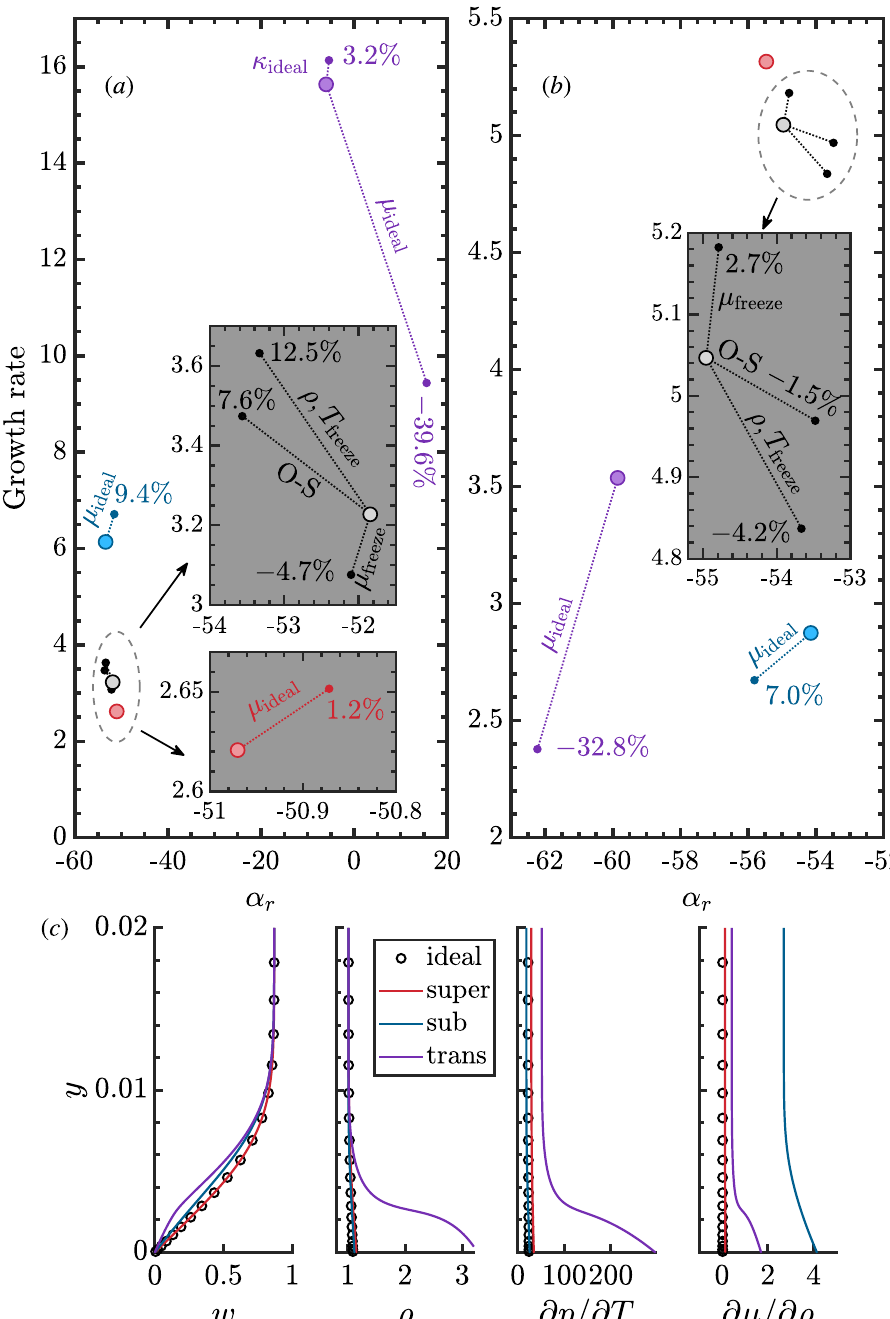
Figure 3. Discrete spectrum of the linear stability corresponding to the colored dots in Fig. 2b and c, β = 80, ω = 15 . Panel ( a ) is for Fig. 2b, cooling wall, and panel ( b ) for Fig. 2c, heating wall. We consider the influence of freezing certain inputs and O–S equations in the ideal regime. The results are denoted with small solid circles with the error of growth rate labeled. In the three non-ideal regimes (red, blue, magenta), we present the influence using ideal viscosity and thermal conductivity inputs. ( c ) Distribution of w , ρ , ∂ p /∂ T , and ∂µ/∂ρ as functions of y for the wall-cooling case. They belong to the velocity and density profiles and thermodynamic gradients originating from the state-variable relation and the transport properties (see Fig.